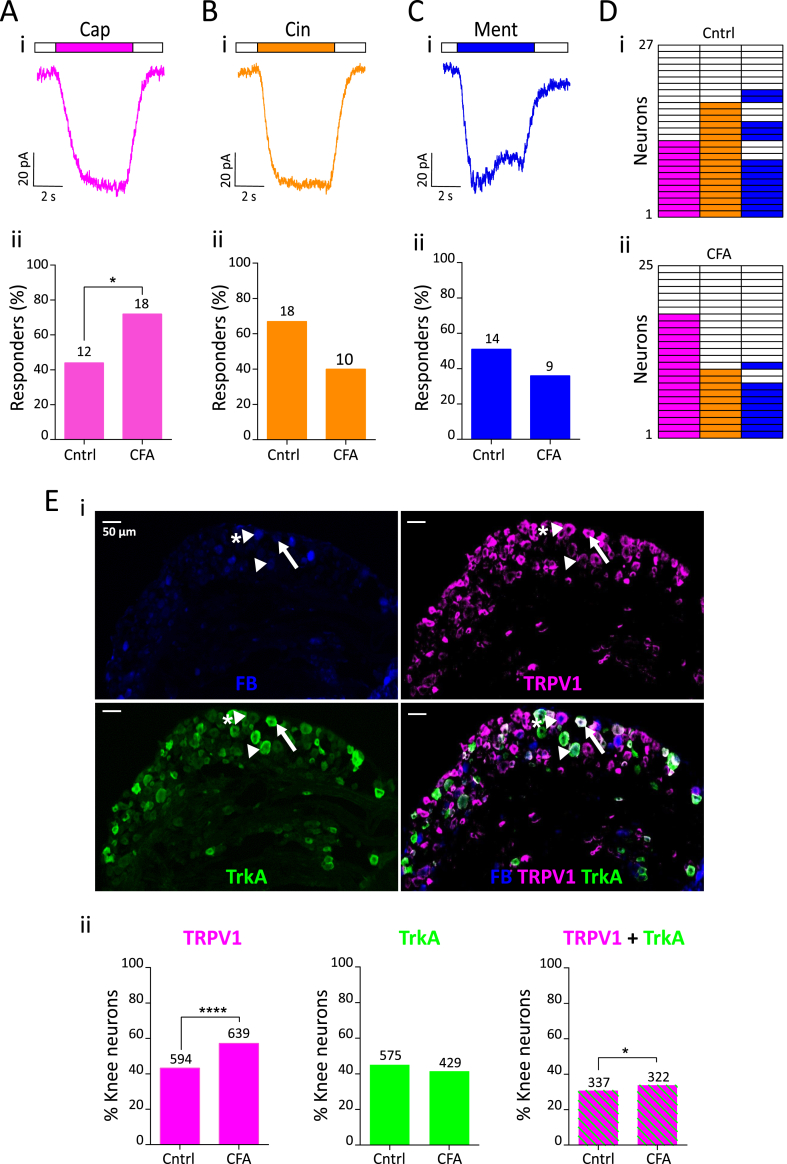
TRP agonist response profile of knee neurons following acute knee inflammation. Representative traces of 10 μM capsaicin (pink, Ai), 100 μM cinnamaldehyde (orange, Bi) and 100 μM menthol (blue, Ci) response from a CFA neuron and their respective percentage frequency (Aii, Bii, Cii). The numbers above the bars indicate the number of responsive neurons. D) Heat map of Cntrl (i, n = 27) and CFA (ii, n = 25) neurons responding to capsaicin, cinnamaldehyde and menthol. E (i) Representative images of a whole DRG section from L4 showing fast blue (FB) labeling from the knee (blue), TRPV1 expression (pink), TrkA expression (green) and a merged image; sections from an animal injected with CFA. White arrowhead shows a knee neuron that only expresses TrkA, white arrowhead with asterisk shows a knee neuron that expresses only TRPV1 and white arrow shows a knee neuron that co-expresses TRPV1 and TrkA. (ii) Proportion of knee neurons (L2-L5) that express TRPV1 (pink), TrkA (green) and both TRPV1 and TrkA (green and pink stripes) from Cntrl (n = 1334) and CFA (n = 1089) injected side. Numbers above the bars represent neurons stained positive with respective antibodies. * indicates p < 0.05, **** indicates p < 0.0001, chi-sq test. (For interpretation of the references to colour in this figure legend, the reader is referred to the Web version of this article.)